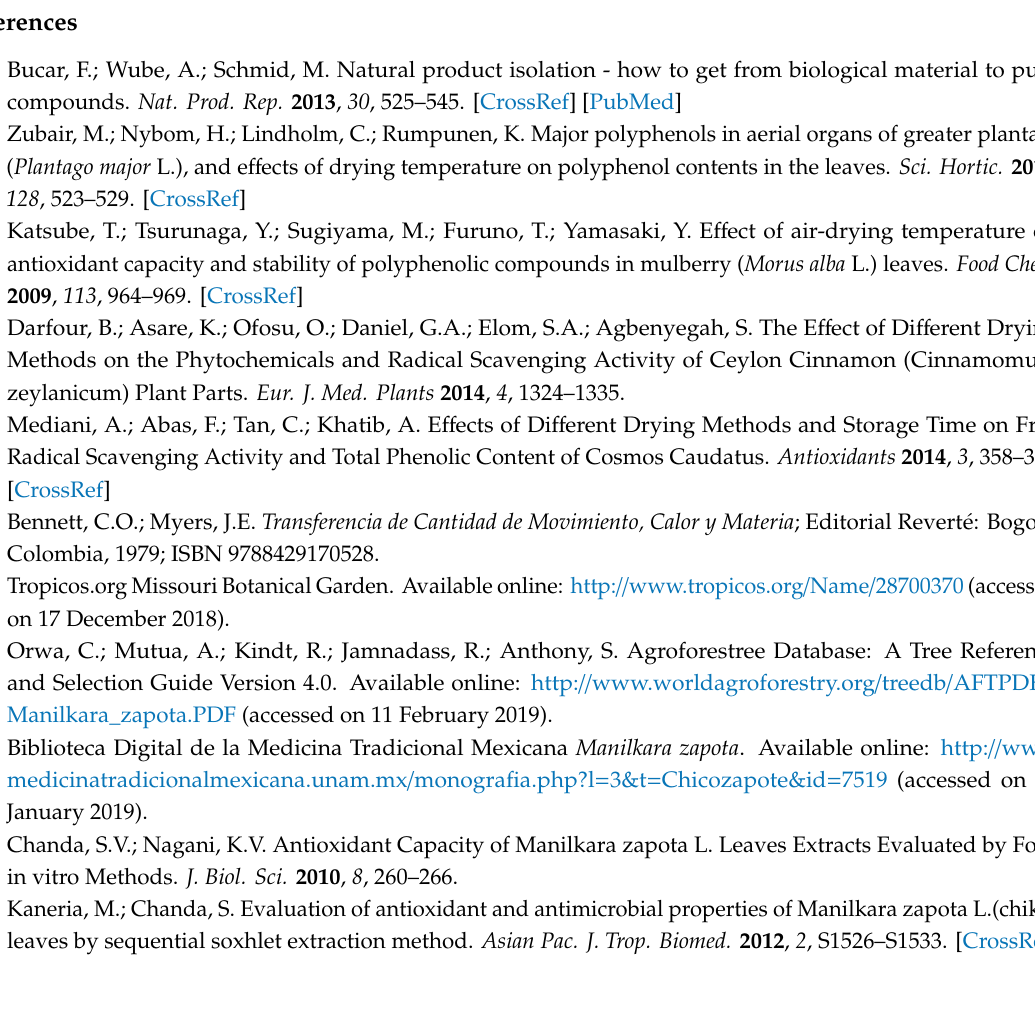
Table S1: Experimental 1 H, 13 C-NMR, COSY, HSQC and HMBC data of the putative myricetin and those reported for the myricetin aglycone, Table S2: Experimental 1 H-NMR data of the putative epicatechin and those reported for the epicatechin, Table S3: Experimental 1 H, 13 C-NMR, COSY, HSQC and HMBC data of the putative ca ff eic acid and those reported for the ca ff eic acid, Figure S1: Representative 1 H-NMR profiles (Region δ 5.0 to 8.1) of the MeOH extracts from M. zapota leaves dried at di ff erent temperatures (T = 25, 50, 75 and 100 ◦ C) showing the characteristic resonances from the detected